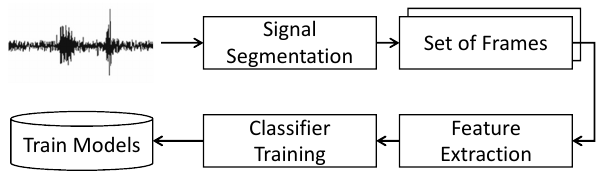
Figure 3. Training of contextual